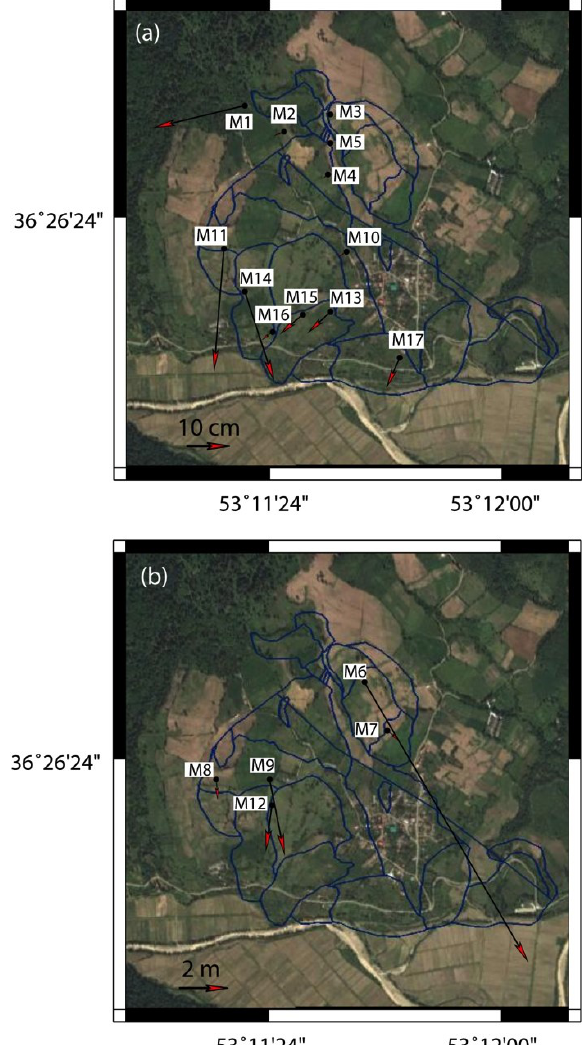
Figure 3: GPS horizontal displacement vectors for a period between 8th of September, 2011 and 7th of May, 2014. (a) Stations with displacement values less than 50 centimetrs. (b) Stations with displacement values up to several meters.